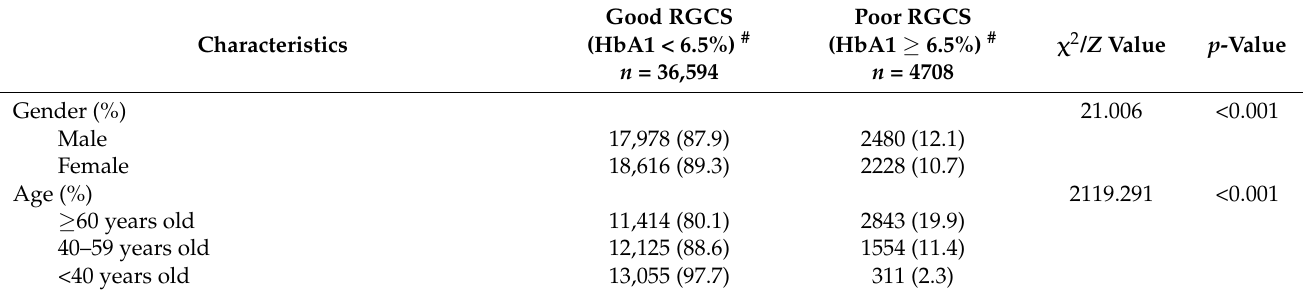
Table 1. Characteristics by RGCS of non-pregnant adults 20+ years old from NHANES 1999–2018 (except for 2003–2004).